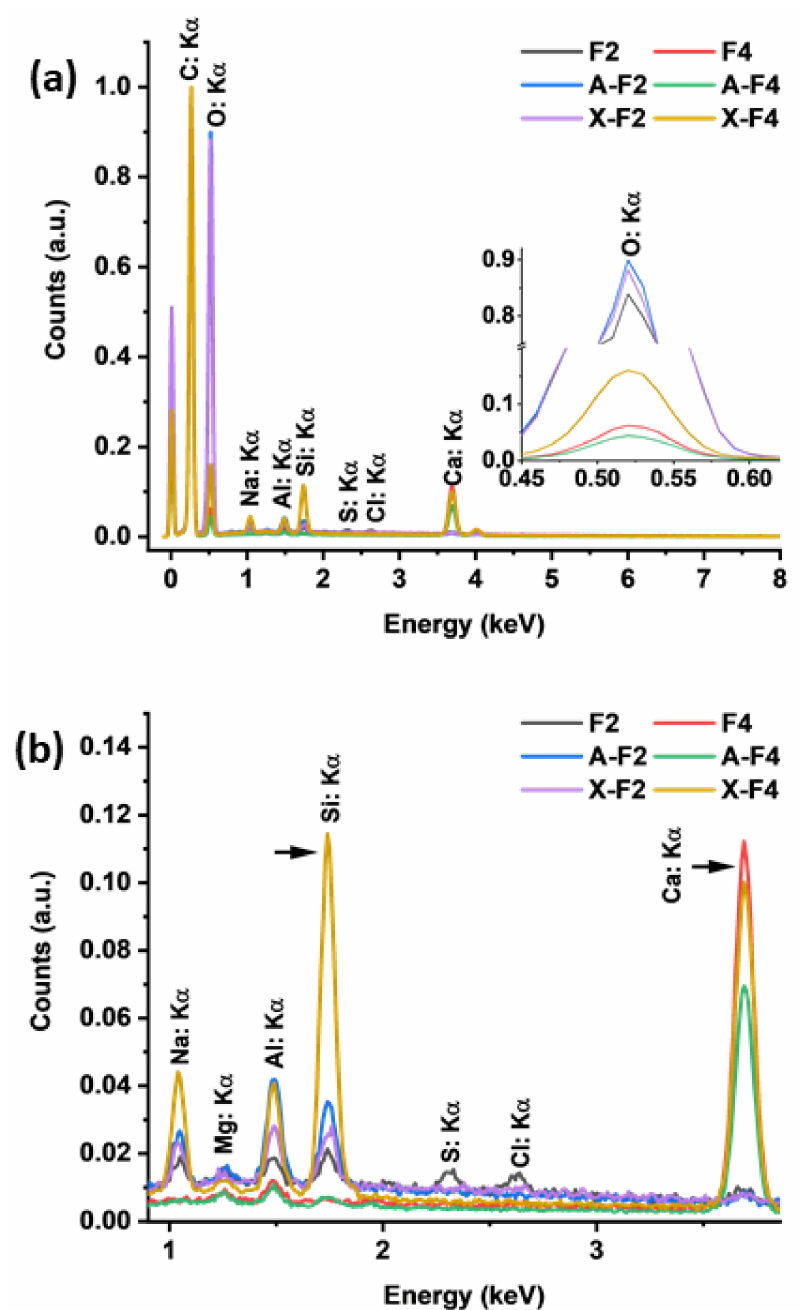
Figure 3. Analysis of elements in fabrics by the EDS: ( a ) full analysis from 0 to 8 keV, ( b ) zoomed region from 1 to 4